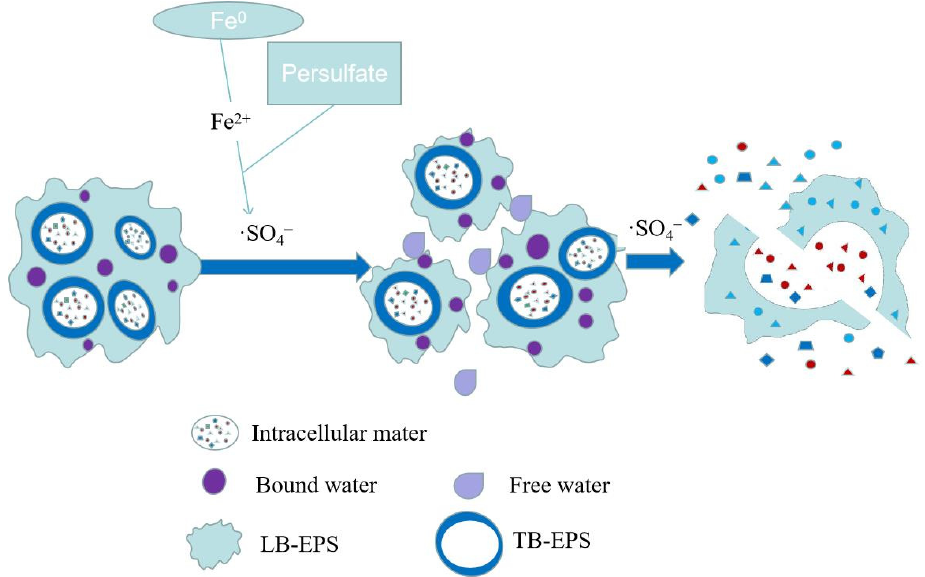
Figure 2. Mechanism of enhanced sludge dewatering by persulfate pretreatment. Zhen et al. used activated persulfate to enhance sludge dewatering for the first time and reported that at room temperature, persulfate in the pH range of 3.0–8.5 was catalytically activated by transition metal ions (Fe 2+ ) and acted on excess sludge, which could significantly improve the sludge dewatering performance [36]. In addition, when the S 2 O 82 − and Fe 2+ were 1.2 mmol/g (calculated by the dosage in 1 g of volatile suspended matter VSS, the same below) and 1.5 mmol/g, the CST decreased rapidly, which could be reduced by 88.8% within 1 min. The · SO 4 − produced by Fe 2+ catalytic activation has strong oxidizing property. · SO 4 − can destroy the floc structure of sludge, release EPS bound water and intracellular bound water, and greatly improve the dewatering performance of sludge. Zhou et al. used zero-valent iron instead of Fe 2+ as S 2 O 82 − inducer and found that when K 2 S 2 O 8 was 4 g/L and Fe 0 was 15 g/L, the sludge CST was reduced by more